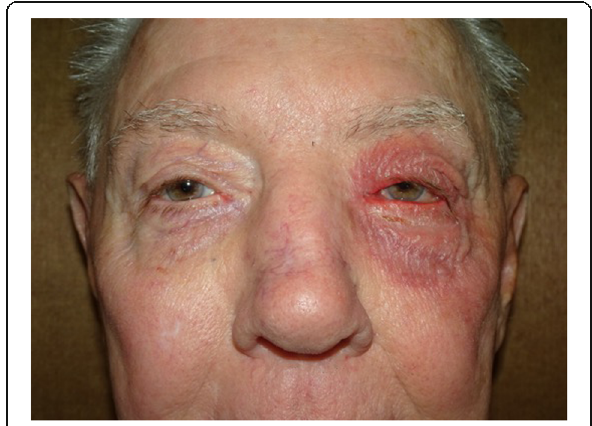
Fig. 1 Patient on postoperative day 7 following left ectropion repair. The patient displays an allergic reaction to the NPD ointment that he applied two to three times a day to the upper and lower eyelid on the left